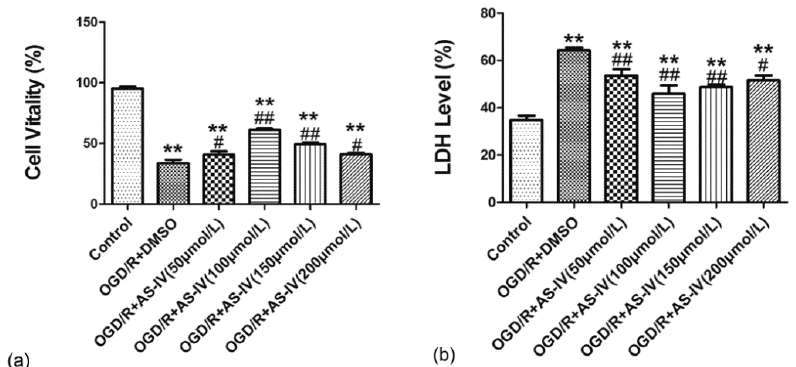
Figure 4. Neuroprotective effect of Astragaloside IV in HT22 cells after oxygen and glucose deprivation/reoxygenation (OGD/R). ( a ) Viability of HT22 cells treated with different concentrations of Astragaloside IV after OGD/R examined by Cell Counting Kit-8 (CCK-8) (means ± SD, n = 6, ** p < 0.01 vs. control and # p < 0.05, ## p < 0.01 vs. OGD/R + dimethyl sulfoxide (DMSO)); ( b ) lactate